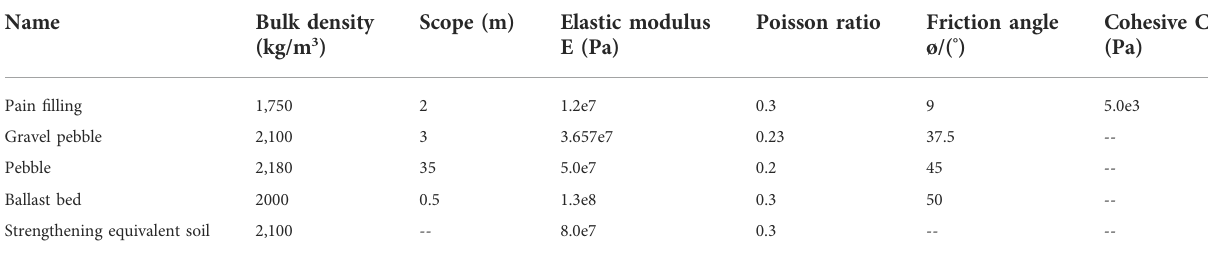
TABLE 4 Ground soil parameters.